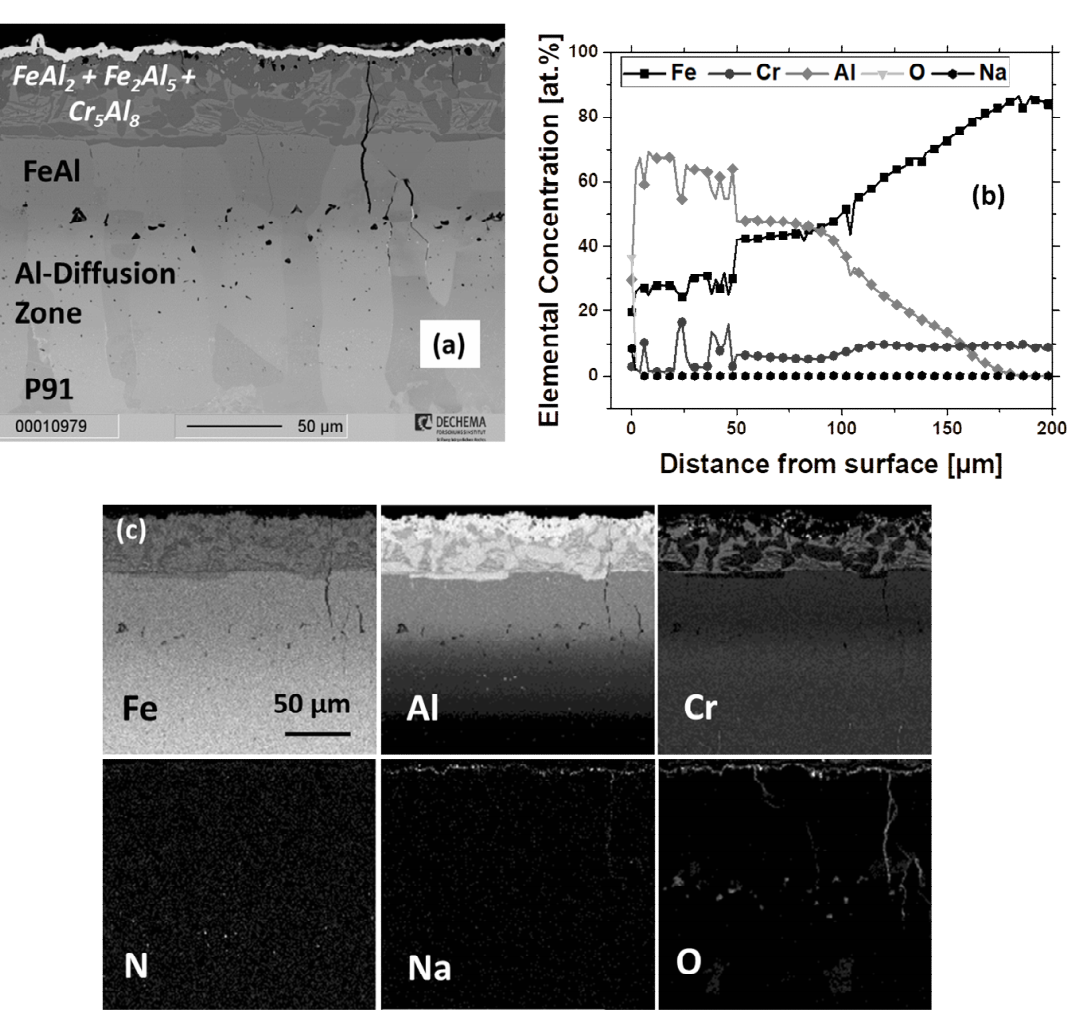
Figure 10. ( a ) Cross-sectional BSE-image, ( b ) quantitative line scans of Fe, Cr, Al, O, and Na, and ( c ) elemental distribution maps of Cr / Al-coated P91 after 1000 h isothermal exposure in molten solar salt at 600 ◦